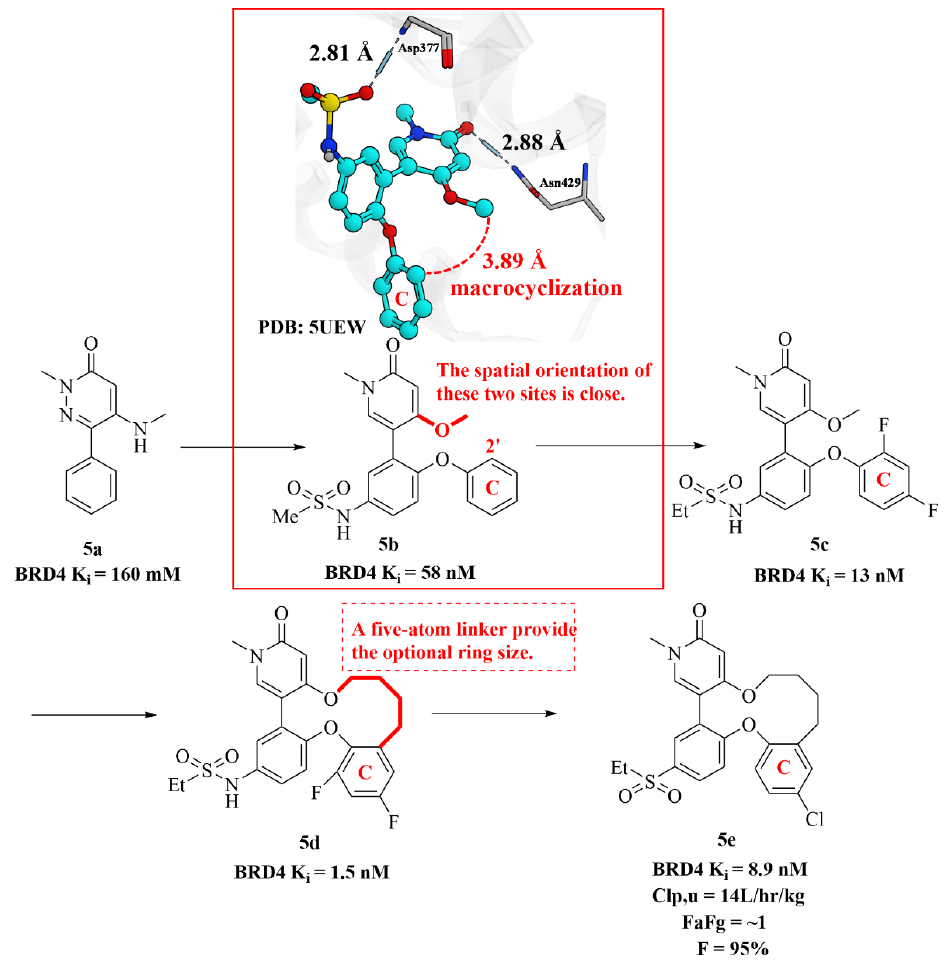
Figure 8. Structural modification of BET macrocycle